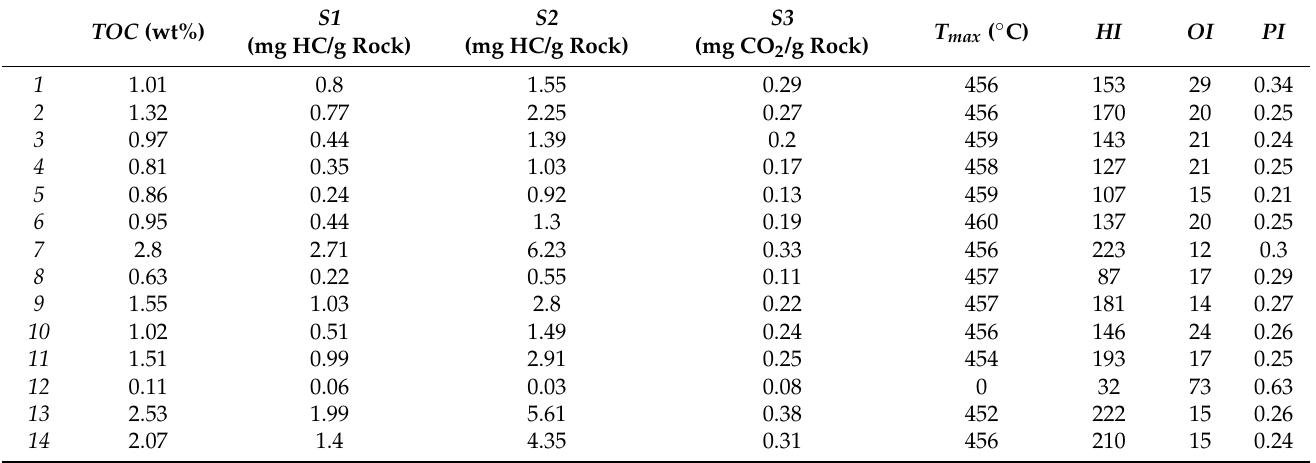
Table 3. Programmed pyrolysis results for a well in the East Feliciana Parish, LA; 14 out of the 60 samples are